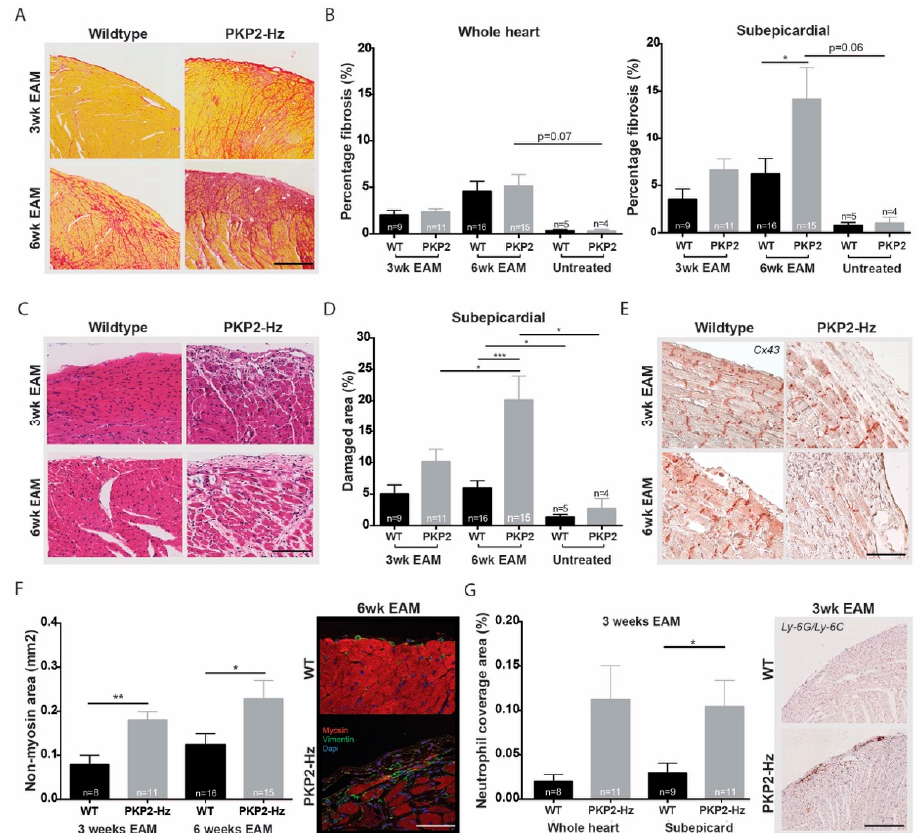
Figure 5. Exaggerated cardiac fibrotic and inflammatory response in PKP2-Hz mice exposed to autoimmune myocarditis. ( A ) Representative pictures of Picrosirius red staining (left panel) of the outer myocardial layer in wildtype and PKP2-Hz murine heart sections, of mice after three weeks of experimental auto-immune myocarditis (3wk EAM) and six weeks of experimental auto-immune myocarditis onset (6wk EAM; scale bar, 750 µ m). ( B ) Quantification of collagen abundance in the entire heart (left panel) and 0.2 mm subepicardial region (right panel) of wildtype (WT) and PKP2-Hz (PKP2) mice after three weeks experimental autoimmune myocarditis (EAM) and six weeks EAM onset or without treatment (untreated; WT 3wk EAM; n = 9, PKP2 3wk EAM, n = 11, WT 6wk EAM; n = 16, PKP2 3wk EAM, n = 15, WT untreated; n = 5, and PKP2 untreated, n = 4, mean ± SEM, * p < 0.05). ( C ) Hematoxylin and eosin (H&E) staining in wildtype and PKP2-Hz heart sections exposed to EAM; scale bar, 500 µ m. (D ) Quantification of damaged area in the 0.2 mm subepicardial layer of wildtype (WT) and PKP2-Hz (PKP2) mice hearts exposed to EAM or without any treatment, quantification was performed on H&E stained heart sections (WT 3wk EAM; n = 9, PKP2 3wk EAM, n = 11, WT 6wk EAM; n = 16, PKP2 6wk EAM, n = 15, WT untreated; n = 5, and PKP2 untreated, n = 4, mean ± SEM, * p < 0.05, *** p < 0.001). ( E ) Representative examples of Connexin 43 (Cx43) immunohistochemistry labeling in the subepicardial region of WT and PKP2-Hz heart sections exposed to EAM; scale bar, 100 µ m. ( F ) Representative examples (right) of myosin (red) and vimentin (green) immunofluorescence labeling and quantification of non-myosin area (left) in wildtype and PKP2-Hz heart sections of mice exposed to EAM; scale bar, 100 µ m. The non-myosin area was examined in the epicardial layer of both ventricles, areas were normalized by the length of the epicardium (WT 3wk EAM; n = 8, PKP2 3wk EAM, n = 11, WT 6wk EAM; n = 16, and PKP2 6wk EAM, n = 15, mean ± SEM, * p < 0.05, ** p < 0.01). ( G ) Quantification of Ly6C / 6G (neutrophil) coverage area (left) in whole heart and 0.2 mm subepicardial regions of wildtype and PKP2-Hz mice after three weeks EAM onset (WT whole heart; n = 8, PKP2 whole heart, n = 11, WT subepicard; n = 9, and PKP2 subepicard, n = 11, mean ± SEM, * p < 0.05). Representative example (right) of the neutrophil positive area in both groups; scale bar, 500 µ